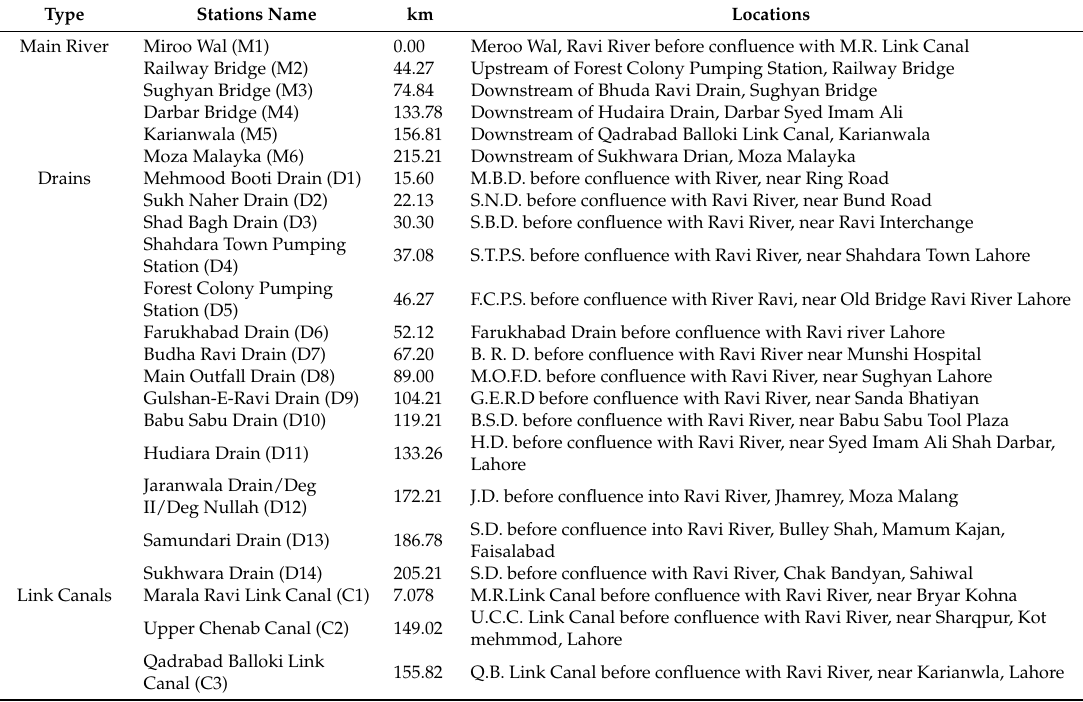
Table 1. Water-quality sampling location in the Ravi River, drains, and link